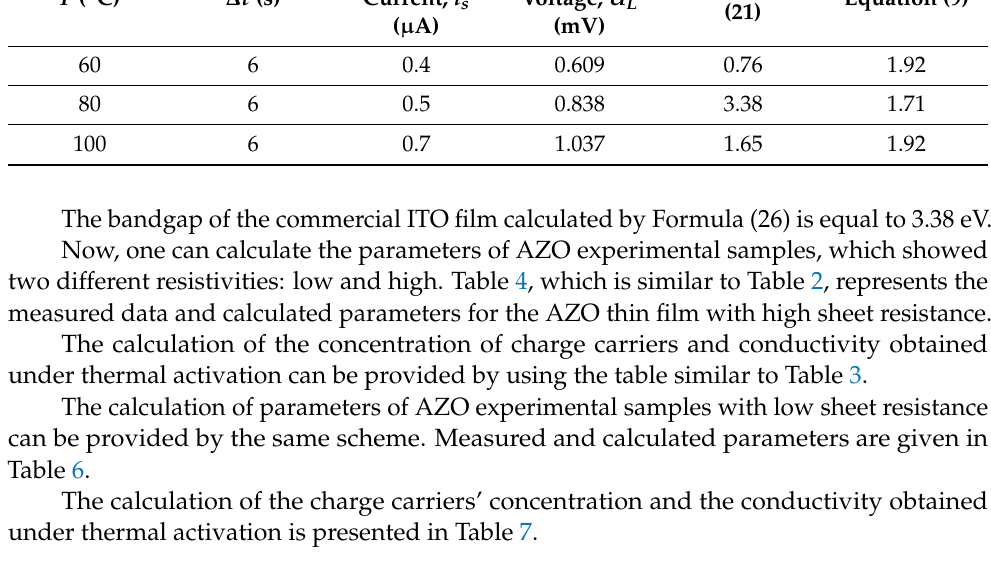
Table 5. Measured voltage and basic calculated parameters of the high-resistance AZO film.